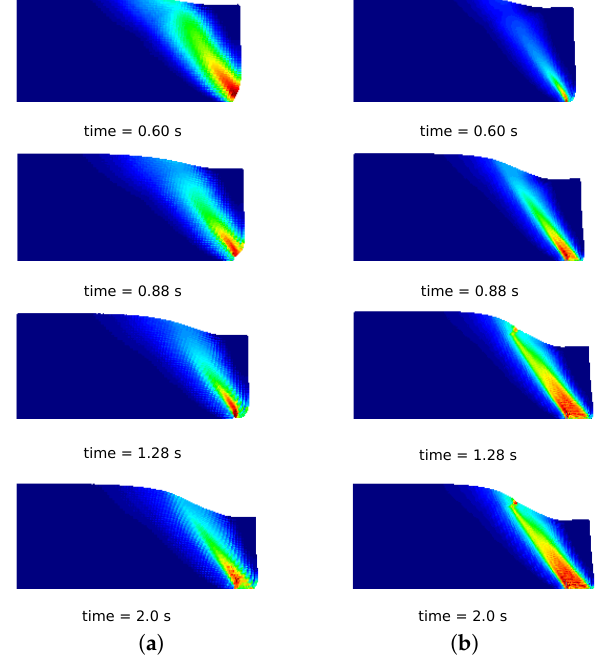
Figure 13. Soil column collapse. Distribution of equivalent plastic strains for different representative time instants in the GMM-LME results. ( a ) Mesh 1; ( b ) Mesh